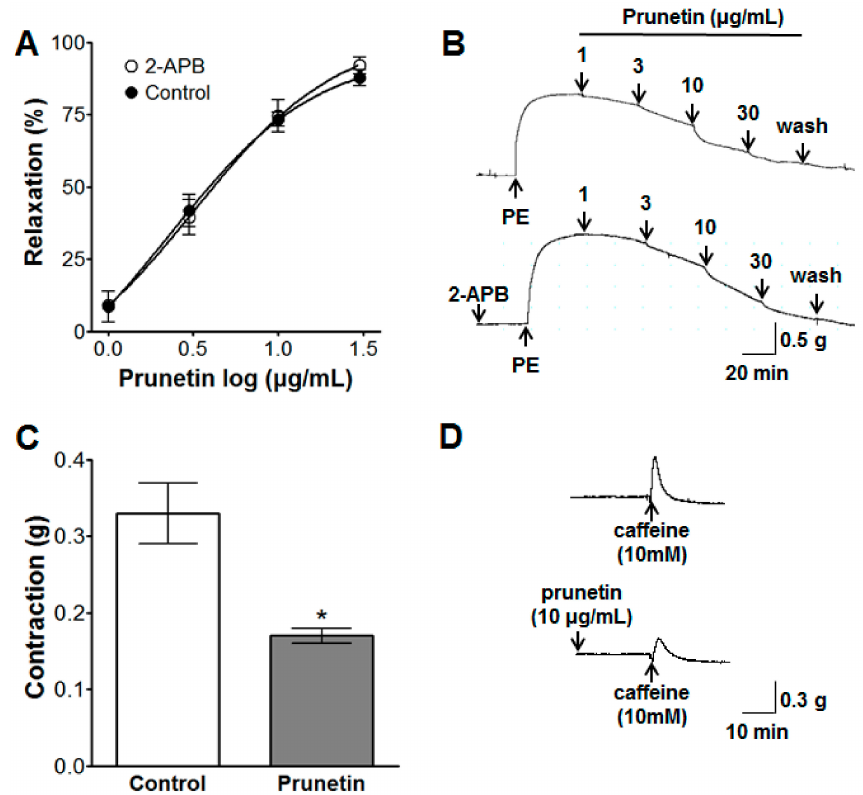
Figure 3. The vasorelaxant effect of prunetin (1–30 µ g/mL) on vessels pre-contracted by phenylephrine (PE, 1 µ M) with or without pre-treatment with 2-aminoethoxydiphenyl borinate (blocker of store-operated Ca 2+ entry, 2-APB) ( A , B ) and the inhibitory effect of prunetin (10 µ g/mL) on vasocontraction induced by caffeine (RyR agonist, 10 mM) ( C , D ). ( B , D ) are representative traces under the indicated conditions. Values are expressed as mean ± SEM ( n = 4–5). * p < 0.05 vs. control.